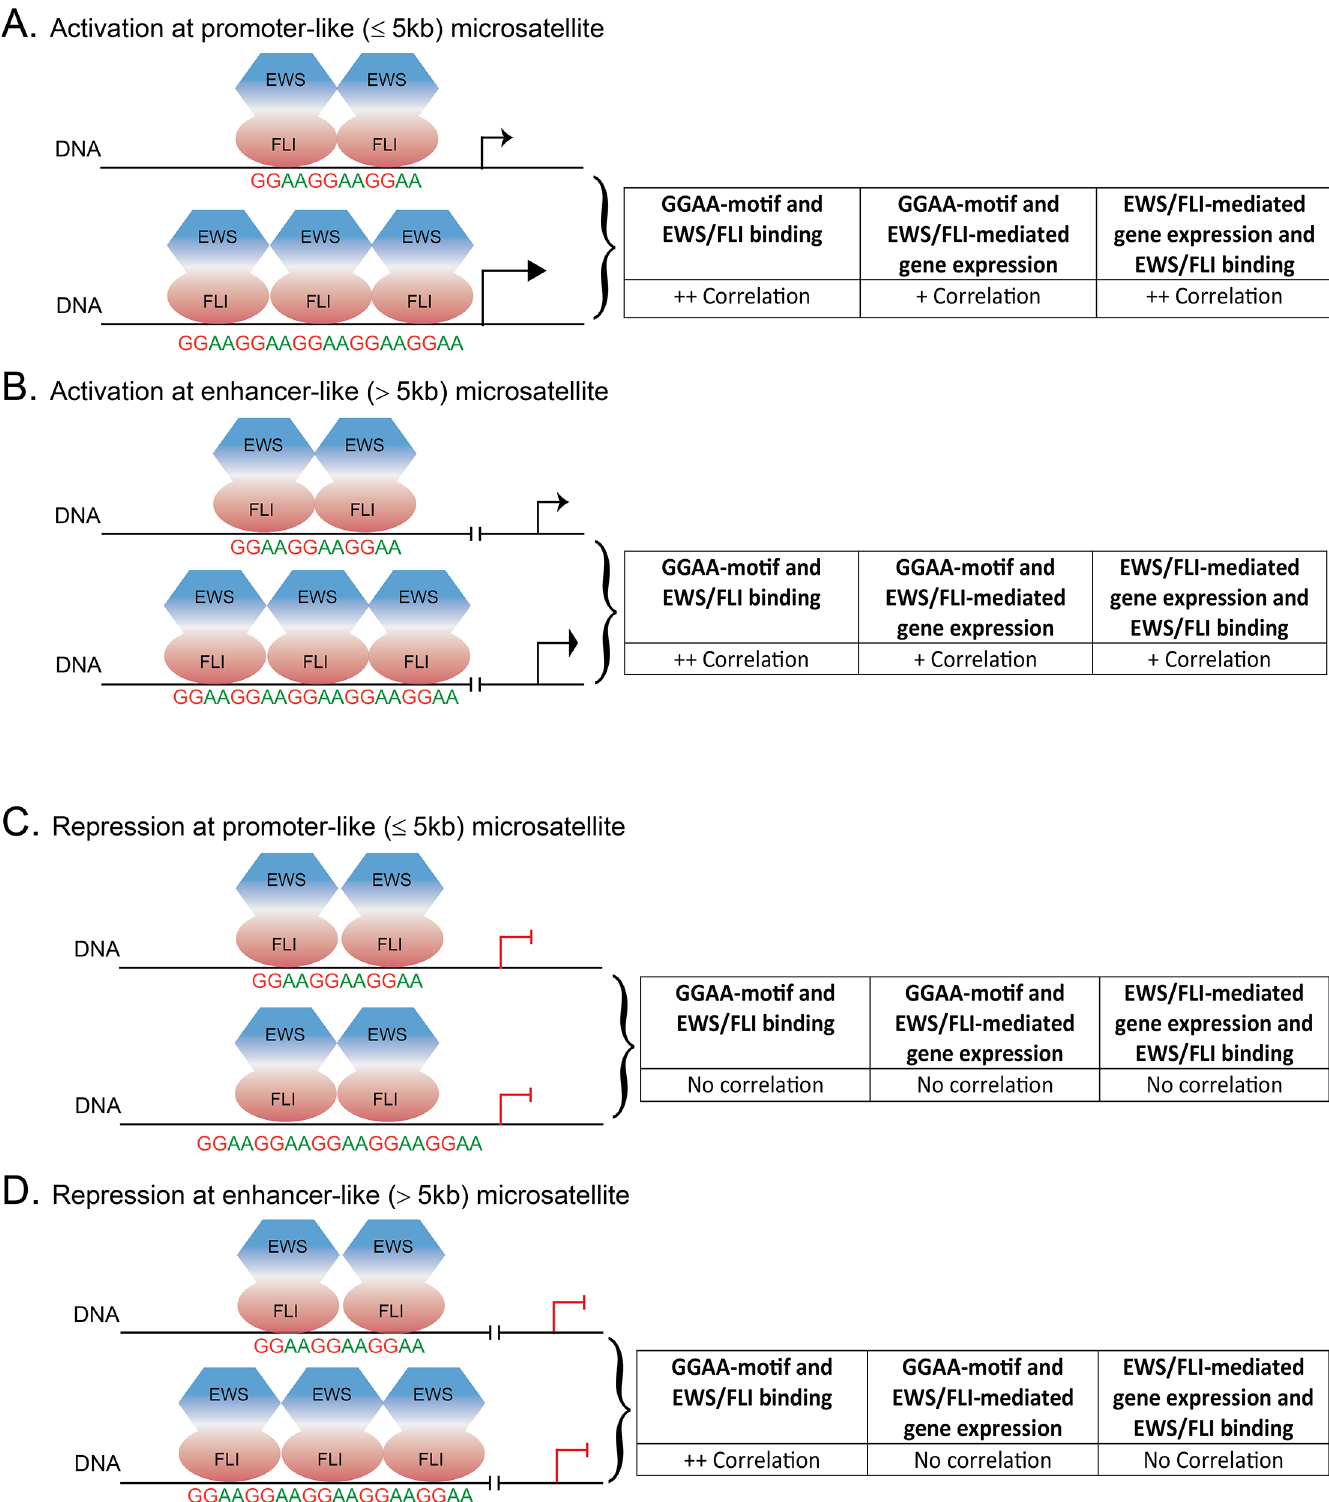
Fig 5. Schema of correlative associations between GGAA motifs in EWS/FLI-bound microsatellites for gene activation and repression. Schematic illustratingEWS/FLI responsiveness at given loci across the genome.( A ) Promoter-like (close-range) GGAA-microsatellitespositivelycorrelate with EWS/FLI bindingand activationof genes in a length dependent manner. ( B ) Enhancer-like (long-range) GGAA-microsatellites positivelycorrelate with